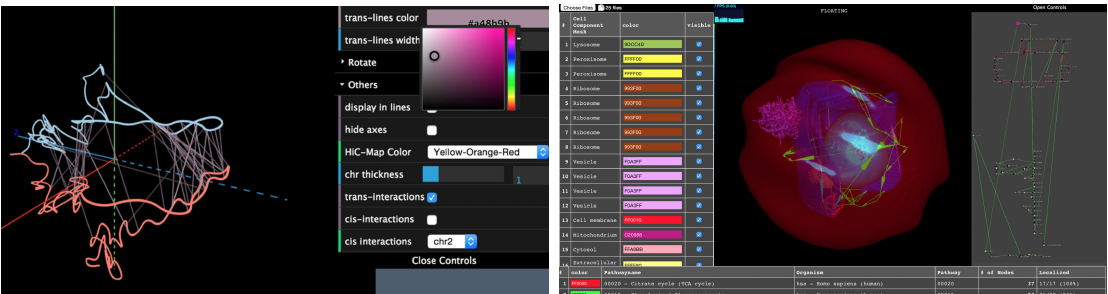
Figure 6. Left: The user interface of the HiC-3DViewer [62] shows chromatin interactions of a Yeast genome where intra- and inter-chromatin interactions are displayed in the form of white straight lines; Right: The user interface of CmPIweb [61] visualizes the citrate cycle and the glycolysis pathway inside an animal cell. The complete cell with pink opacity is shown in the center of the UI with additional glycolysis pathway on the left. Components of the cell like ribosomes, mitochondium, etc. can be selected on the left in different color